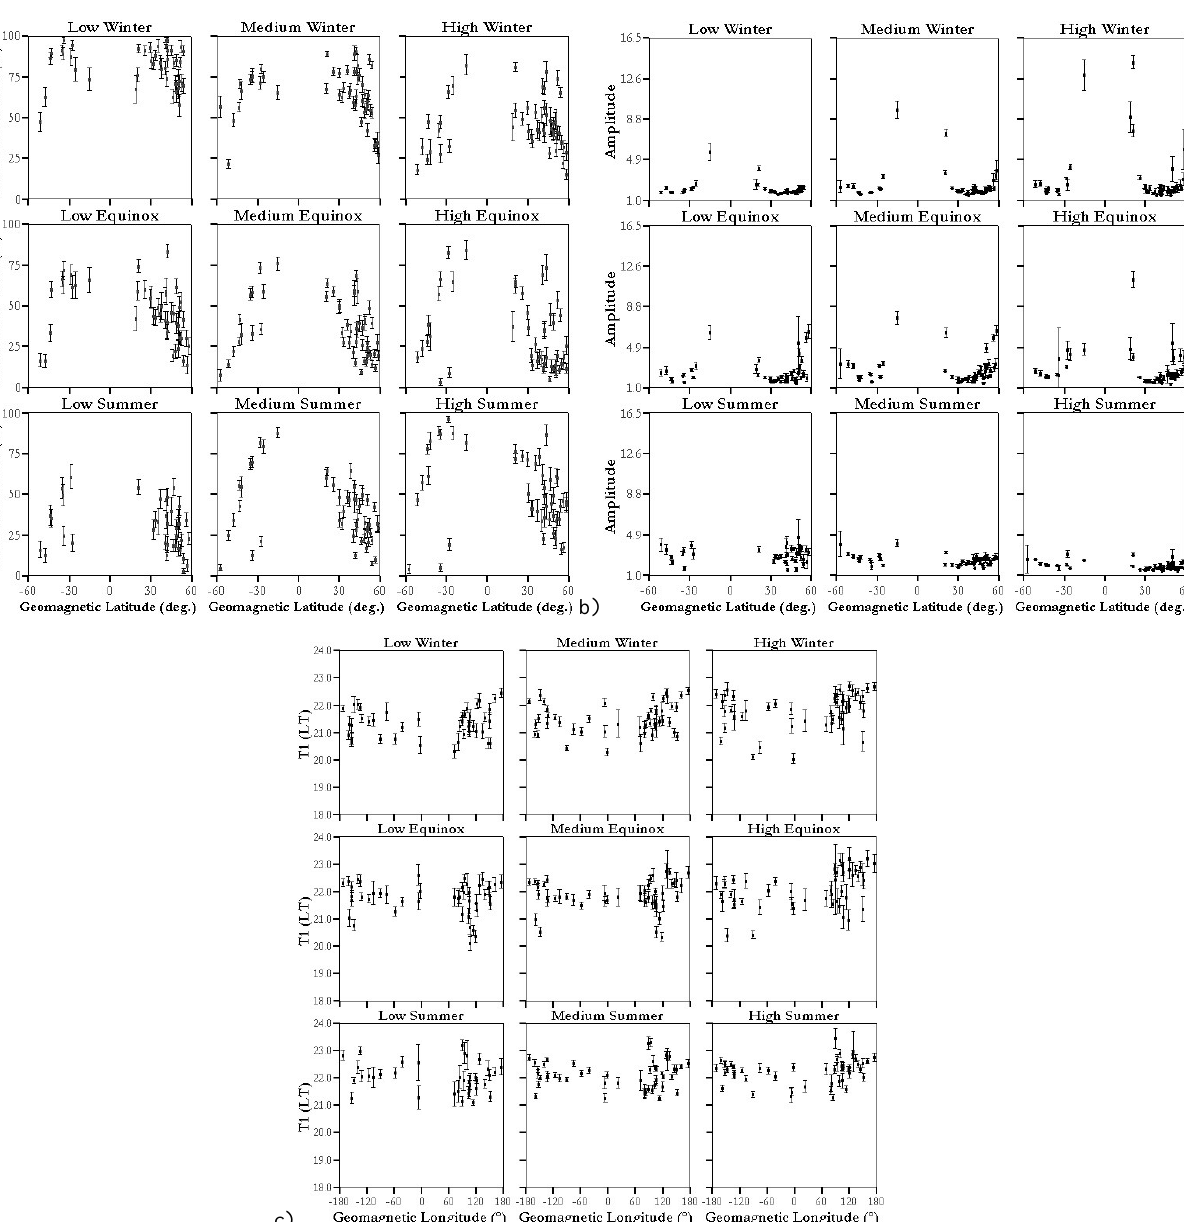
Fig. 4. Geographic variation with of characteristic parameters for the first peak (a) probability of occurrence, (b) relative amplitude, and (c) local time of occurrence with geomagnetic longitude, under different seasonal and solar conditions. Categories are the same as in Figs. 2 and 3. For example, “Low winter” refers to winter data under low solar activity conditions. Points indicate means. Bars indicate 95% confidence